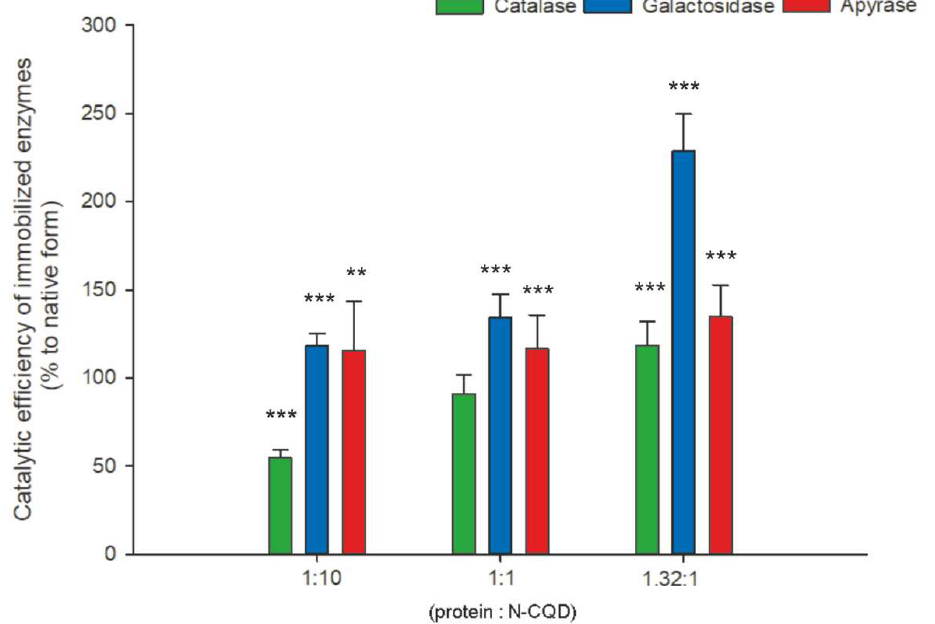
Figure 5. Comparison of catalytic efficiency of immobilized enzymes. The statistical significance of the differences is related to native enzymes and marked on the graphs with asterisks (* for p ≤ 0.05, ** for p ≤ 0.01, *** for p ≤ 0.001).